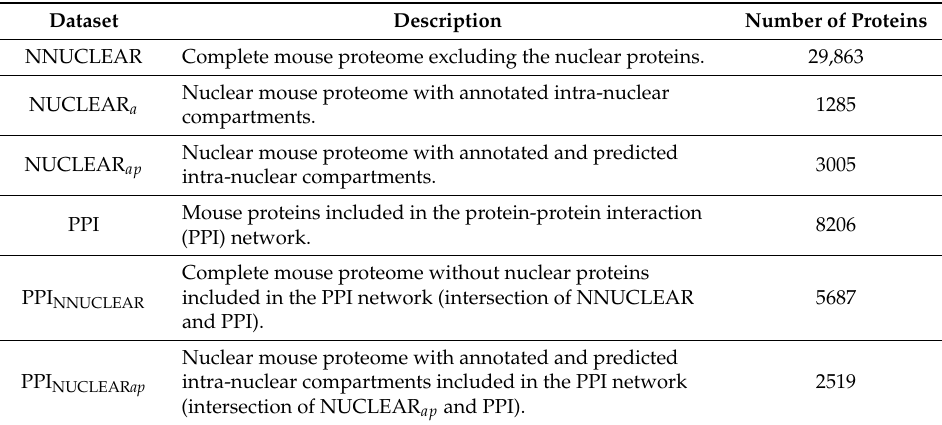
Table 1. Datasets used in this